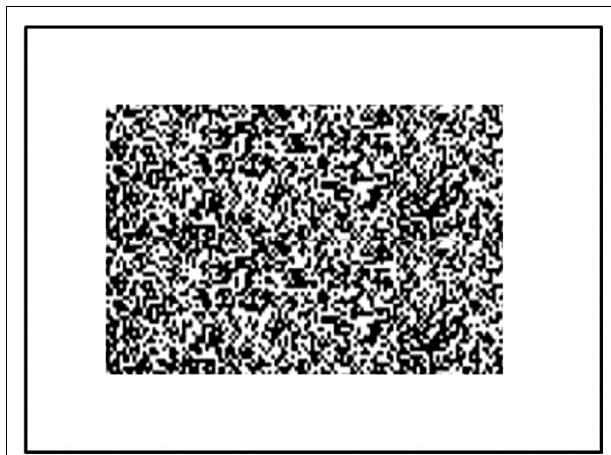
FIGURE 1 | Static visual noise (SVN), a screen of random black and white squares. Dynamic visual noise (DVN) is achieved by changing black boxes (10 × 10 pixels) to white and vice versa at a rate of 291 per